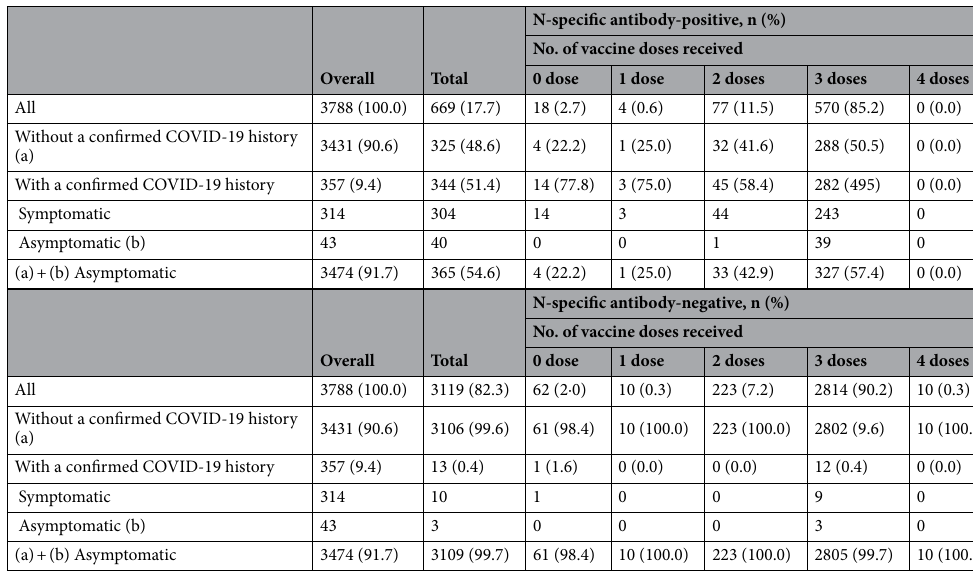
Table 2. N-specific antibody results (positive vs. negative) by confirmed previous COVID-19 infections (N =